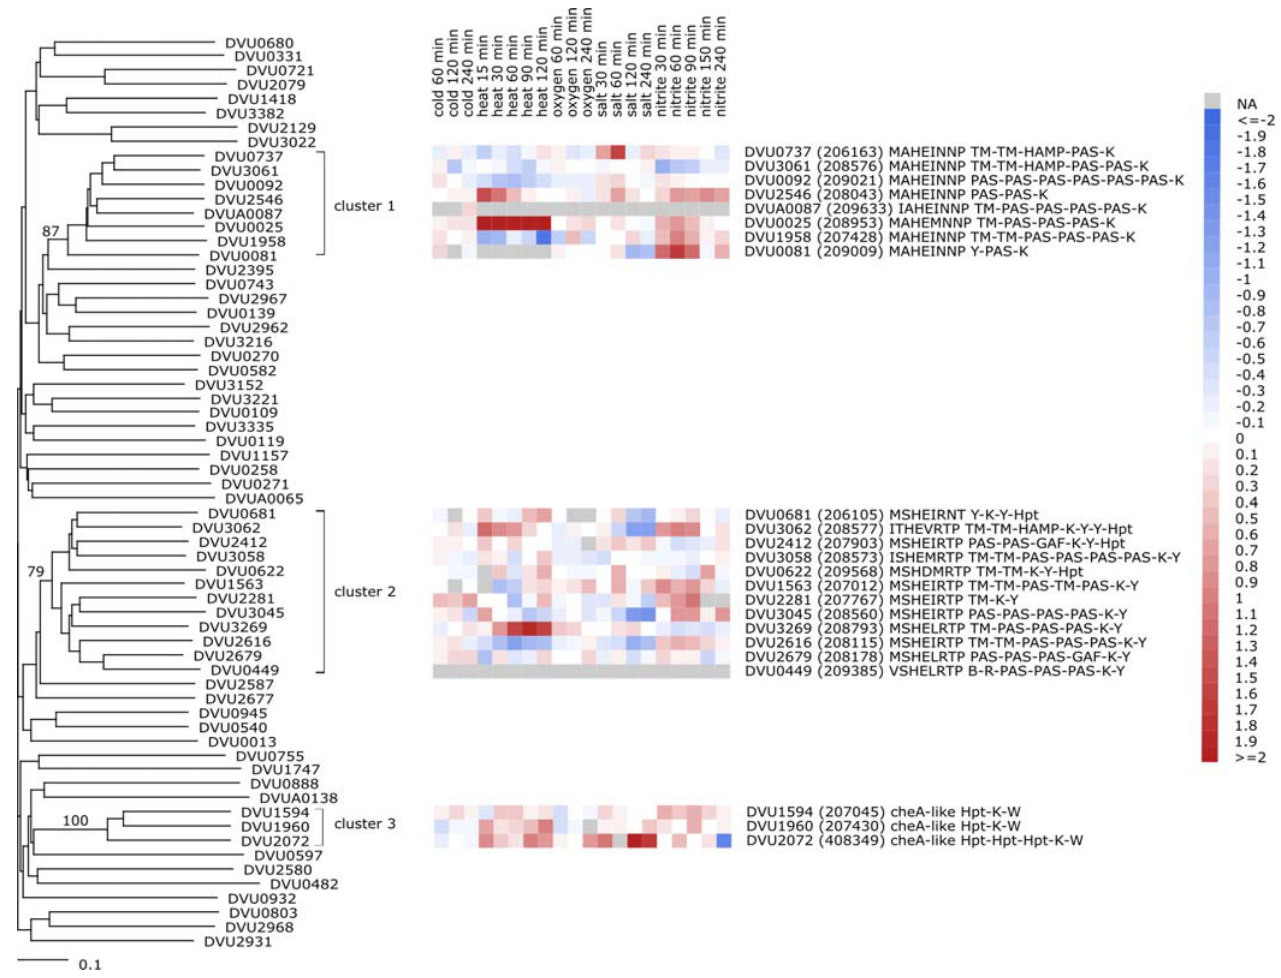
Figure 9. Gene Expression of D. vulgaris Expansions Gene expression profiles across a compendium of experimental stress response conditions (NaCl, heat shock, cold shock, nitrite, and oxygen) were monitored using DNA microarrays, and shown next to a phylogenetic NJ tree (with 1,000 bootstraps, generated using the MEGA3 software package [28]) of all HPK domains in D. vulgaris. Blue colors indicate down-regulated genes (relative to unperturbed cells), and red colors indicate up-regulated genes. No significant excess correlation in gene expression was observed for genes within each cluster (compared with randomly chosen pairs of genes) using a Student’s t-test to compare mean correlations or the Kolmogorov-Smirnov test to compare distributions. The domain structure of each gene in the three LSEs is shown to the right. Gene names are provided for all genes, and MicrobesOnline accession numbers are provided in parentheses for genes in each of the major clusters for comparison with Figure 8. Bootstrap values are provided for each of the major clusters, and the amino acid sequence of the ‘‘ H-Box ’’ motif for genes in each cluster is shown. A more detailed description of the experiments performed is given in